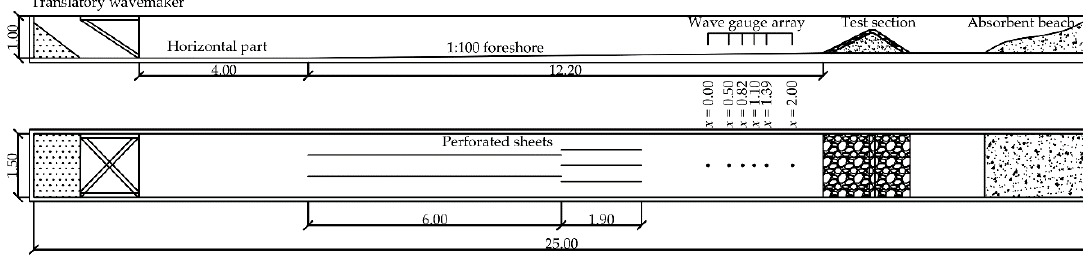
Figure 2. Experimental setup of the flume. Measurements are in meters.